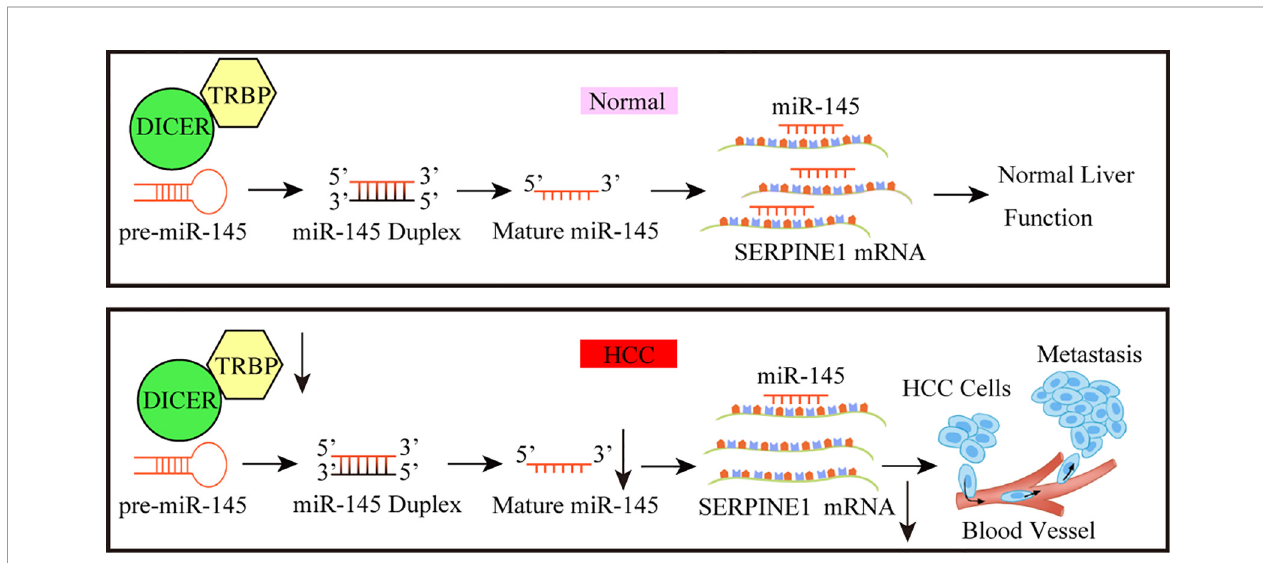
FIGURE 8 | A working model for the TARBP2-miR-145-SERPINE1 axis in HCC progression. The loss of TARBP2 induces the upregulation of SERPINE1 through reducing the processing of miR-145. This linear TARBP2-miR-145-SERPINE1 axis is involved in proliferation, migration, and invasion in HCC